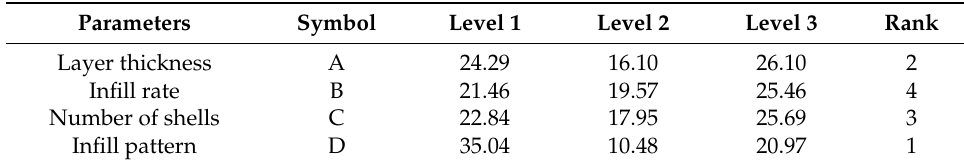
Table 4. Response values for signal-to-noise (S / N) ratio.